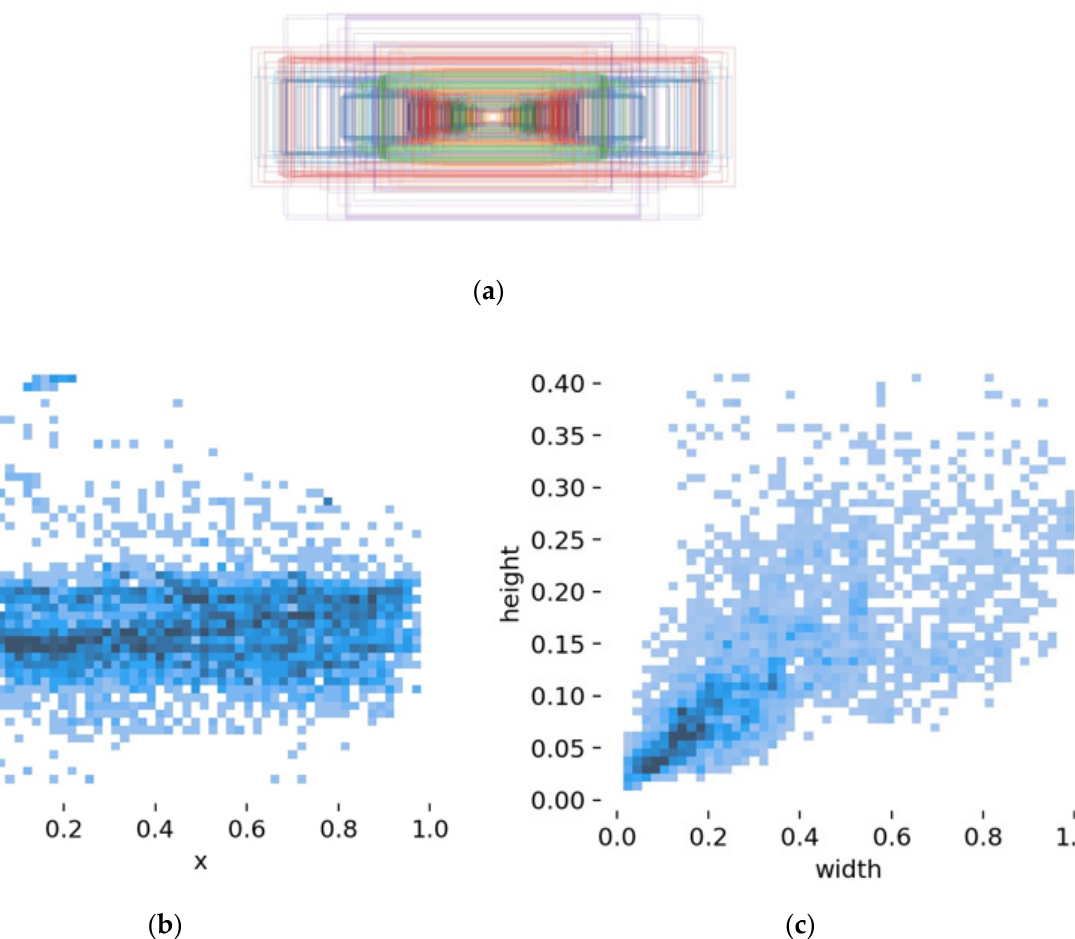
Figure 6. Statistical results of sample data: ( a ) anchor frame distribution map; ( b ) normalized target location map; ( c ) normalized target size map.